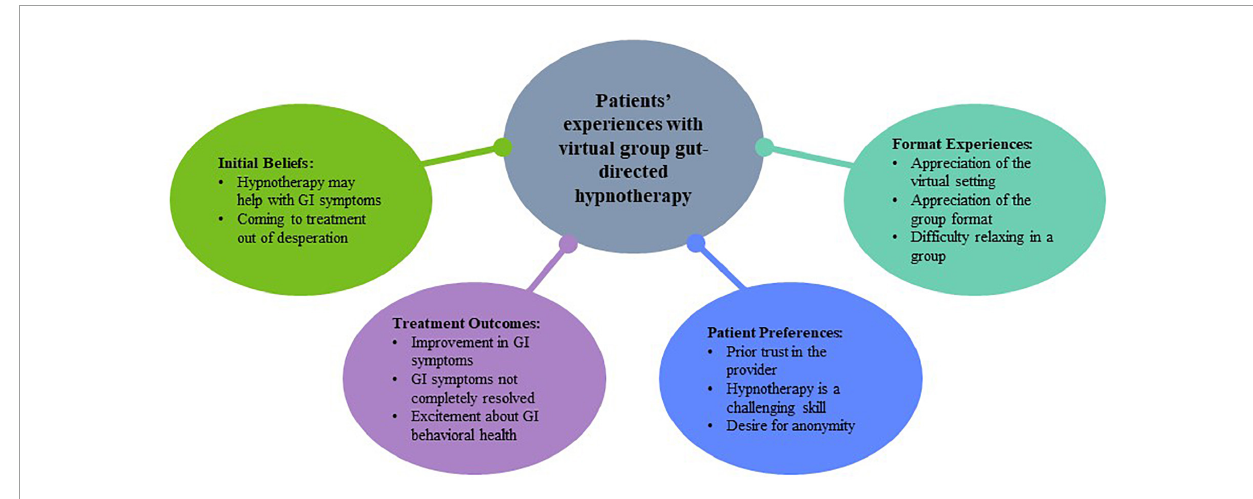
FIGURE1 Consolidated themes describing patient experience with virtual group gut-directed.